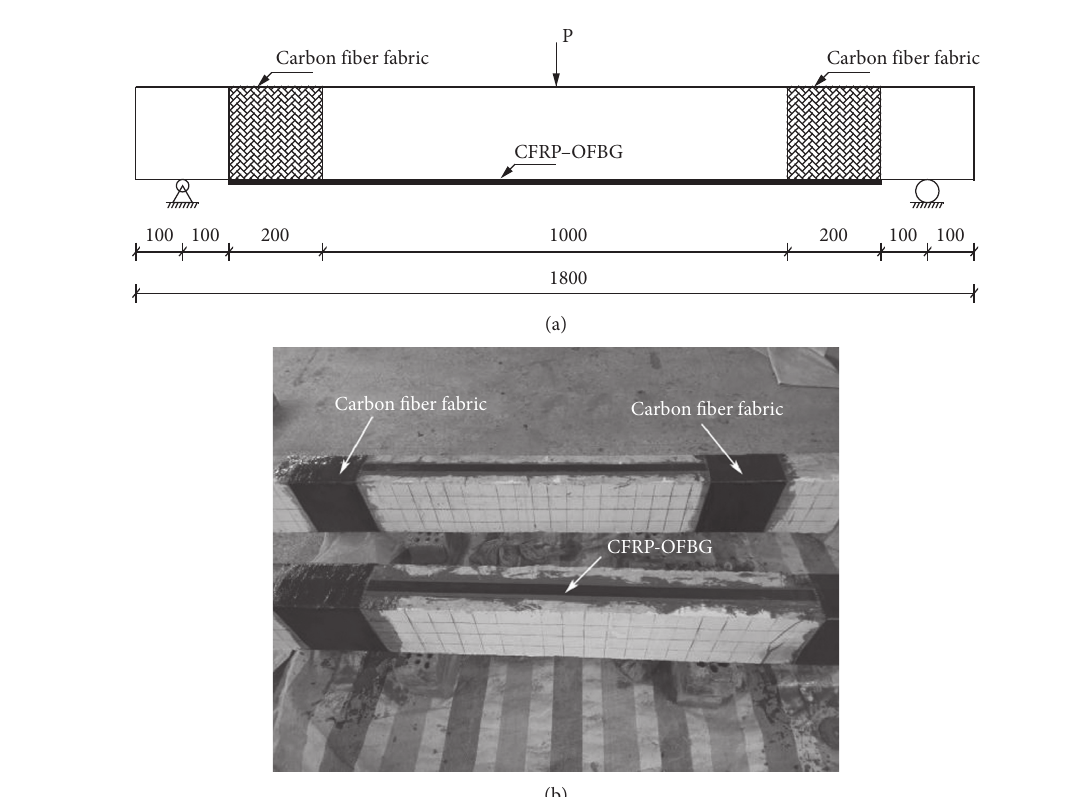
Figure 2: CFRP-OFBG plate reinforced concrete beam diagram.